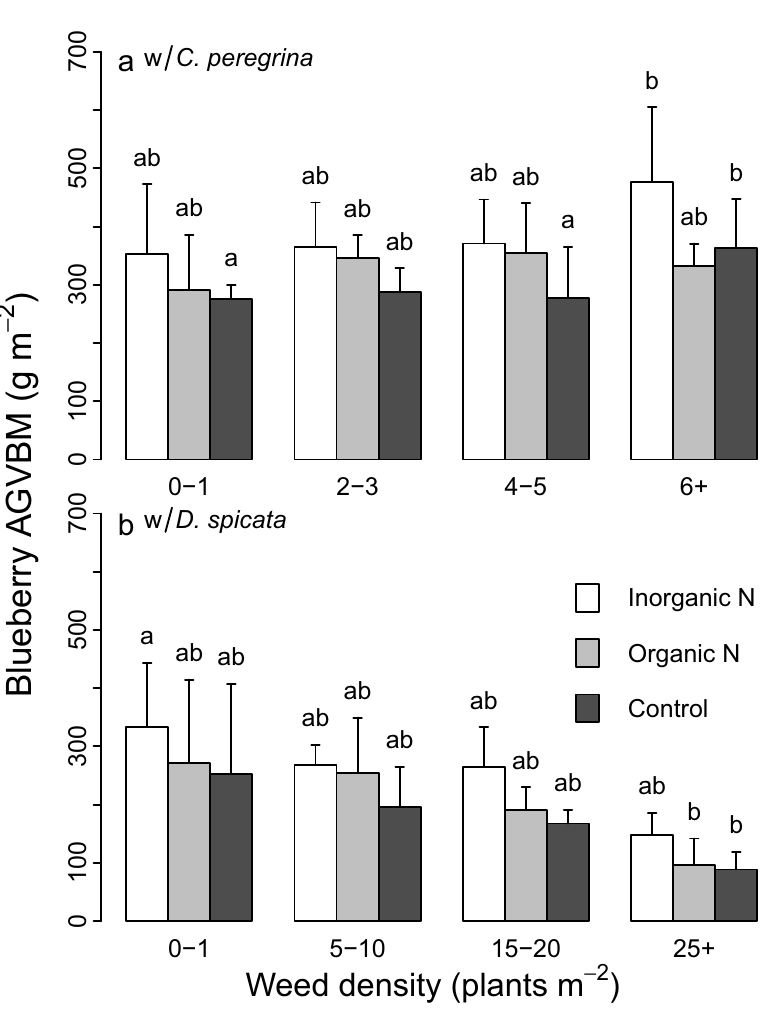
Fig 4. Lowbush blueberry aboveground vegetative biomass (AGVBM) at the end of the production cycle (g m -2 ). AGVBM values (mean ± SD) are shown for the three fertilization treatments (inorganic N-fertilization, organic N- fertilization, and control plots) and the four levels of weed density. (a) Lowbush blueberry AGVBM in plots of C . peregrina ; (b) lowbush blueberry AGVBM in plots of D . spicata ; bars of AGVBM values not sharing the same letters are significantly different ( P < 0.05).